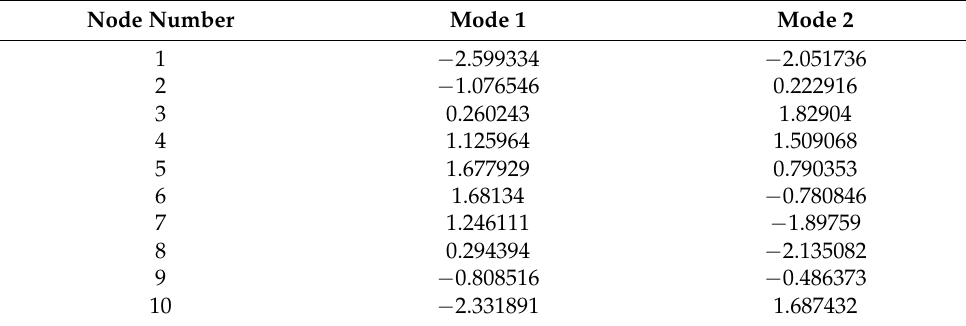
Table 5. Experimental normalized mode shapes obtained from the modal test of the intact steel beam.